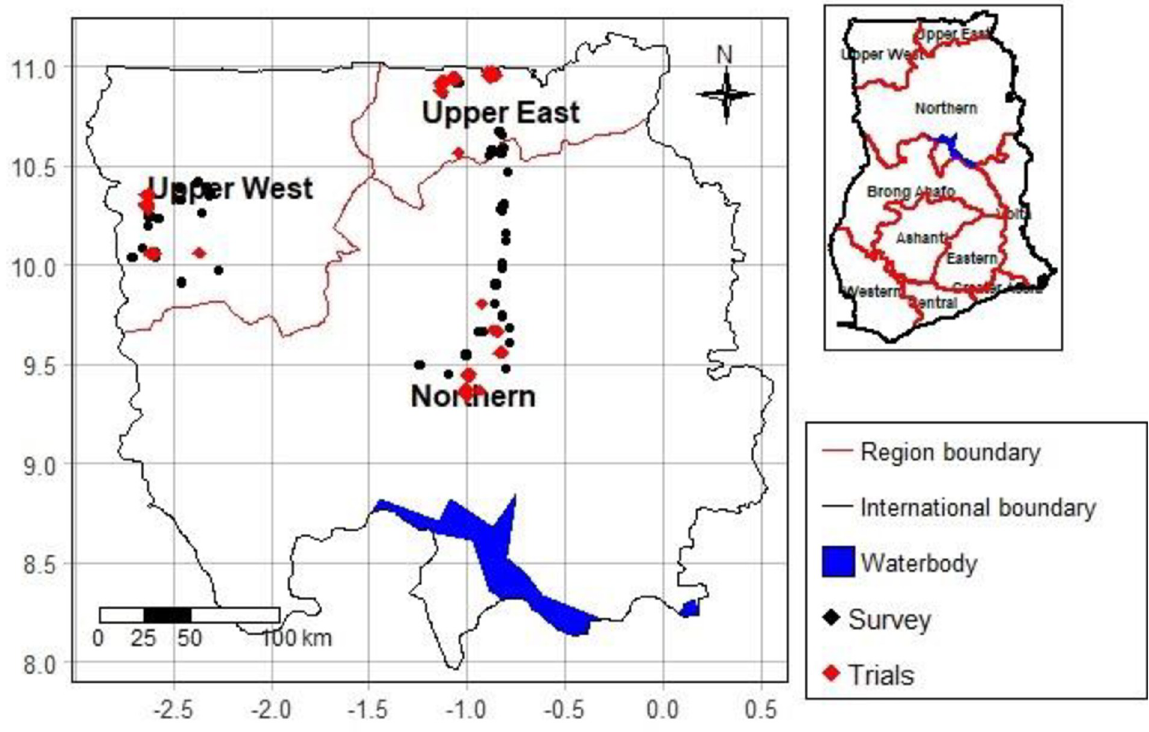
Fig 3. Location of trial sites and survey sites in the study areas. Source: The administrative layers were downloaded from the Global administrative boundaries database (GADM) which does not need license for academic publishing (https://gadm.org/license.html).